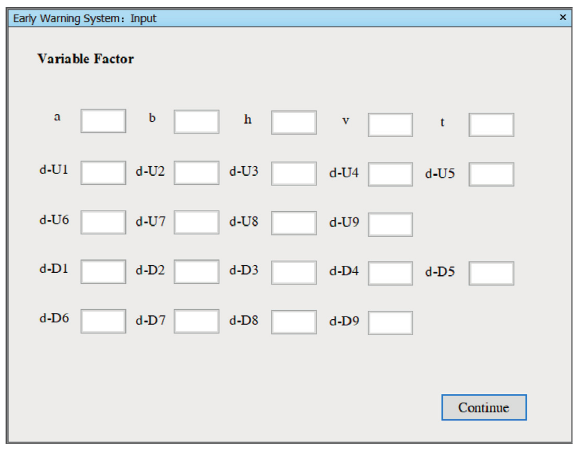
Figure 14: Manual input interface for variable factors.